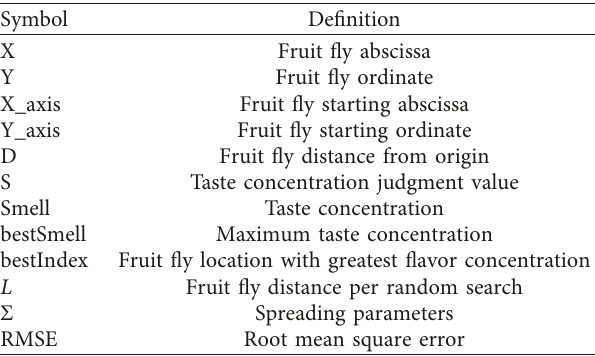
Table 2: The definitions of